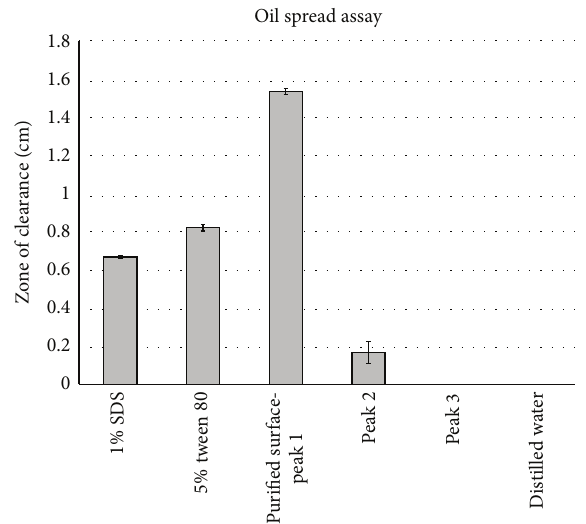
Figure 6: Oil spread assay for study of surface activity of different peaks along with standard surfactants and distilled water as control.